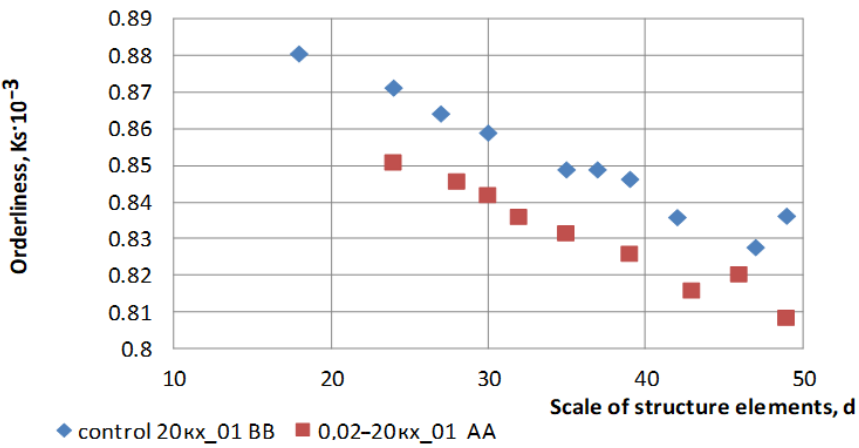
Figure 6. The effect of the d scale on change in the information entropy of D 1 in the spectrum of levels of dynamic state of the information system of modified and control microstructures.